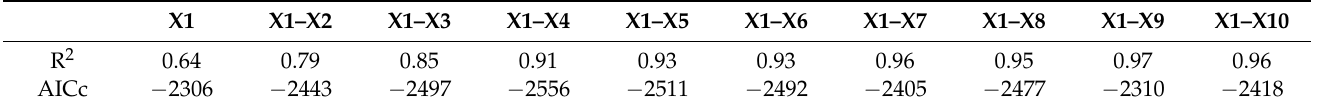
Table 7. Model performance with gradually increasing independent